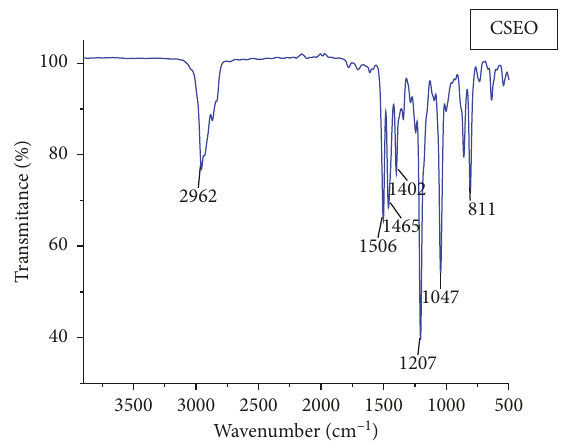
Figure 3: Fourier transform infrared (FTIR) spectra of CSEO. Table 2: Antibacterial activity of various concentrations of CSEO solution against test microorganisms by agar well diffusion. S.No.